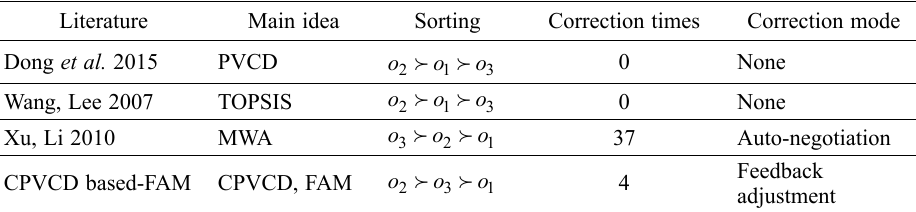
Table 3. Comparison with previous decision-making approaches